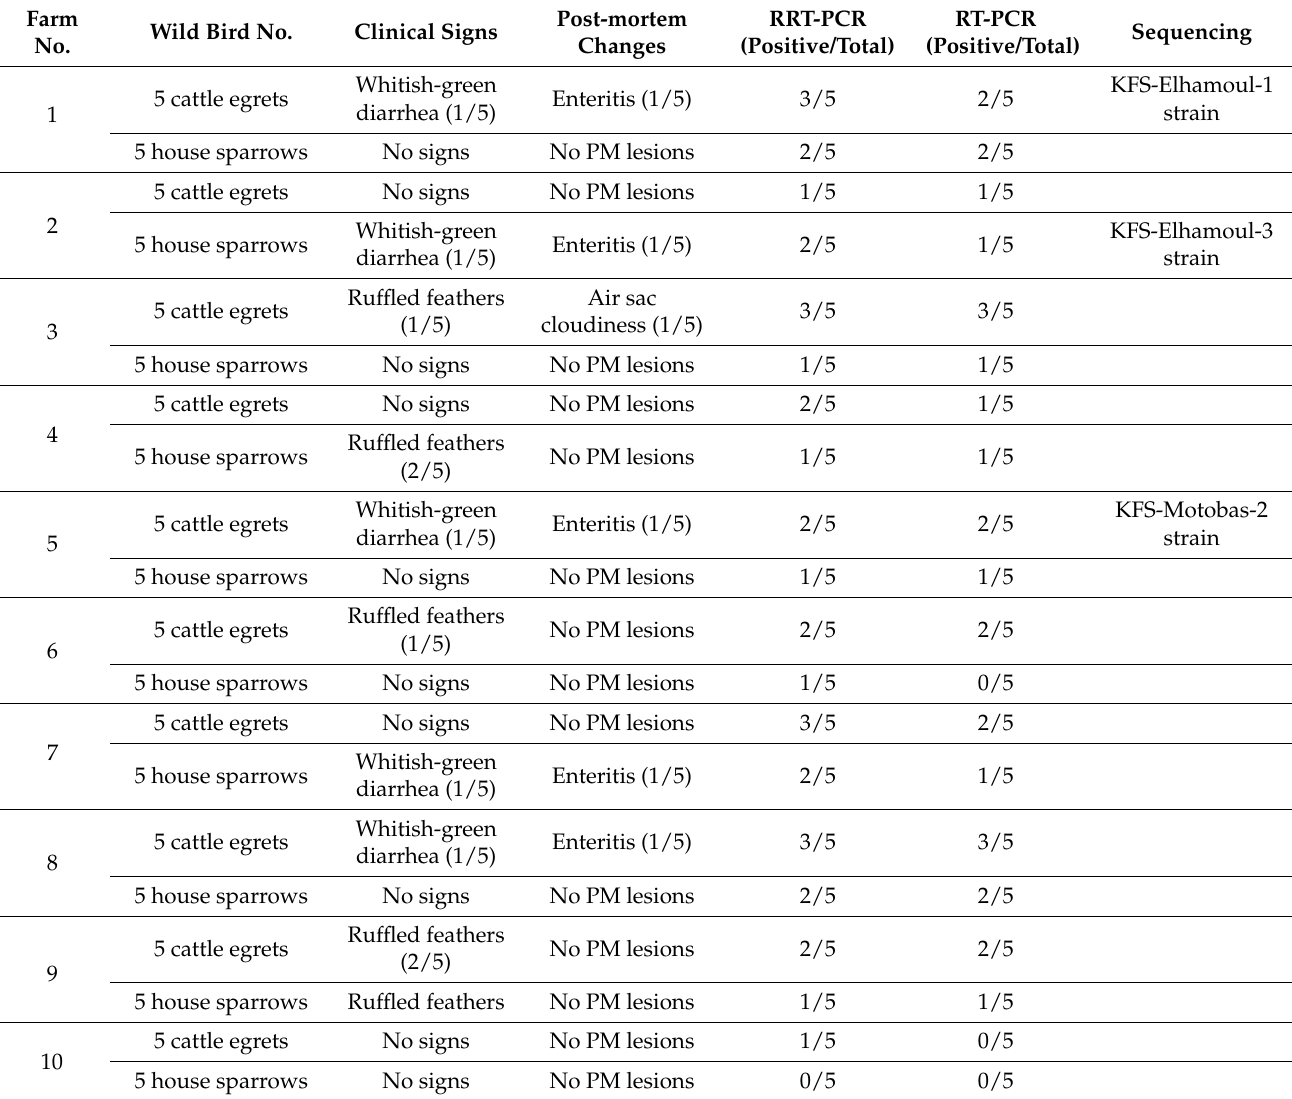
Table 3. Details of collected samples, including the number of collected wild birds; clinical signs; postmortem lesions; and results of RRT-PCR, RT-PCR, and sequencing. Farm Wild Bird No.